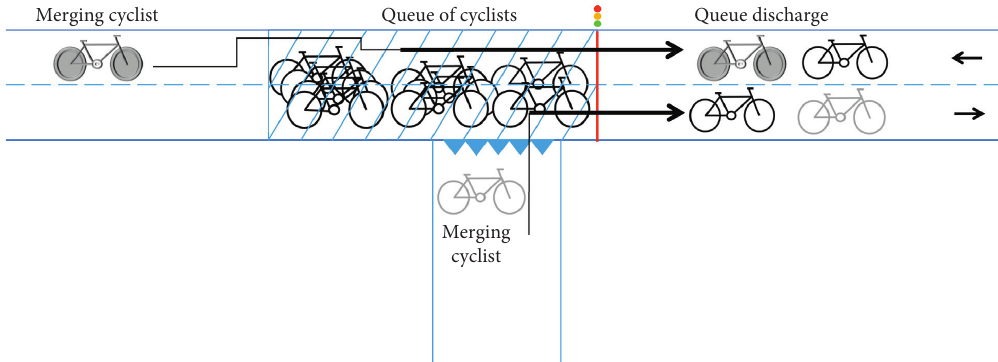
Figure 1: Sketch of a queue discharge process: the original queue is indicated by the black cyclists in the hatched area, and the black arrows indicate merging cyclists who skip part of the queue and join the discharge before the queue is